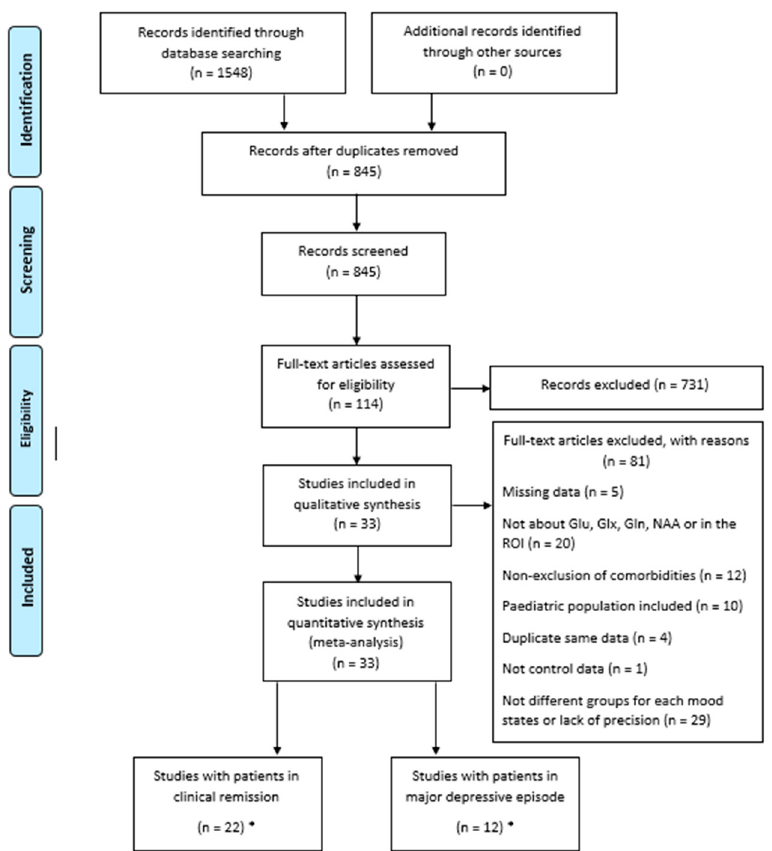
Figure 1. Preferred reporting items for systematic reviews and meta-analyses (PRISMA) diagram for study search. * One study featured two groups (clinical remission and depressive episode) and thus was counted twice, once in each category.